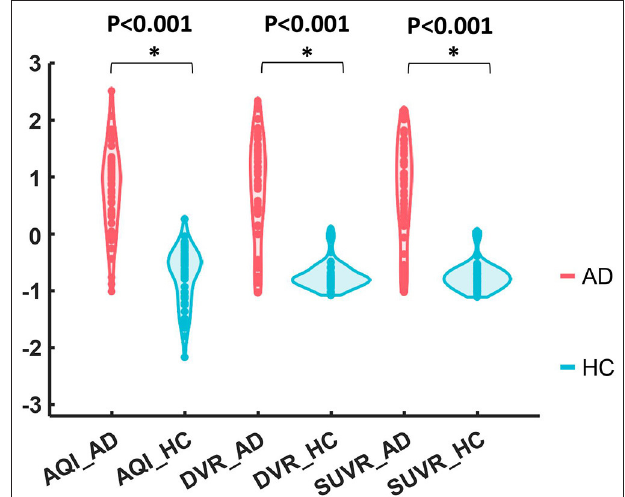
FIGURE 5 | Boxplots of DVR, SUVR, and AQI for AD and HC. For each method, the corresponding data were Z-score normalized to have mean 0 and standard deviation 1 for visual comparison.